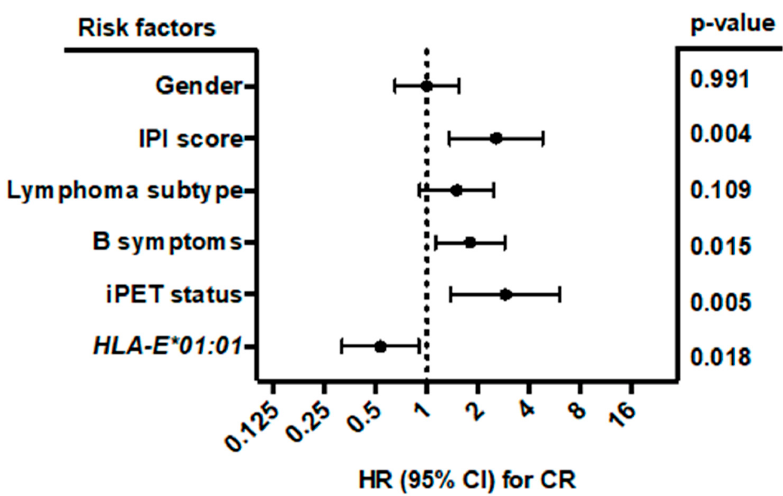
Figure 5. Forest plot of risk factors for CR. The forest plot visualizes the multivariate analysis (binomial logistic regression) of the following parameters: gender (male vs. female), IPI score (0–3 vs. 4–5), lymphoma subtype (DLBCL vs. other), B symptoms (A vs. B), iPET status (favorable vs. unfavorable iPET), and HLA-E*01:01 allele carrier status ( HLA-E*01:01 / *01:01 or HLA-E*01:01 / 01:03 , vs. HLA-E*01:03 / 01:03 ). All clinical data were available for 414 out of 441 patients. The analysis showed that besides B symptoms, IPI score, and iPET status, the HLA-E*01:01 allele carrier status was an independent prognostic risk factor for the prediction of CR. CI = confidence interval, HR = hazard ratio, CR = complete